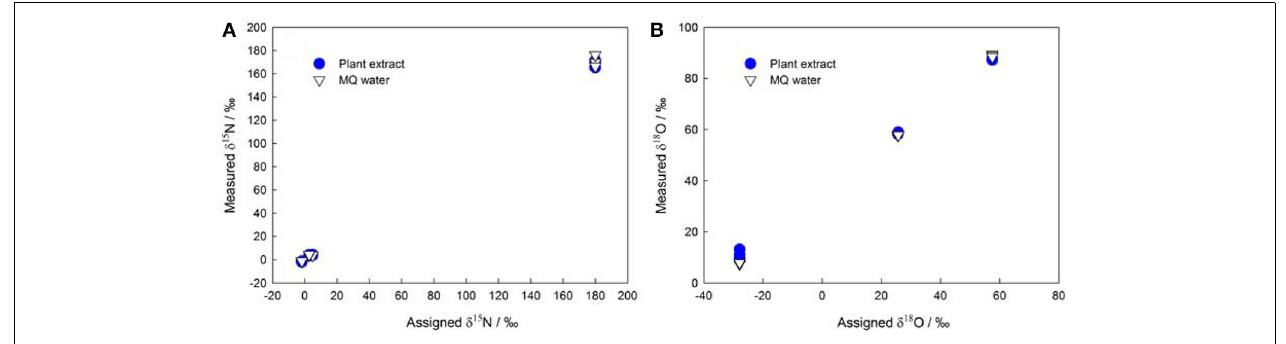
water and in plant extracts (the initial NO − 3 in plant extracts was removed using the same protocol as that described in Liu et al.,